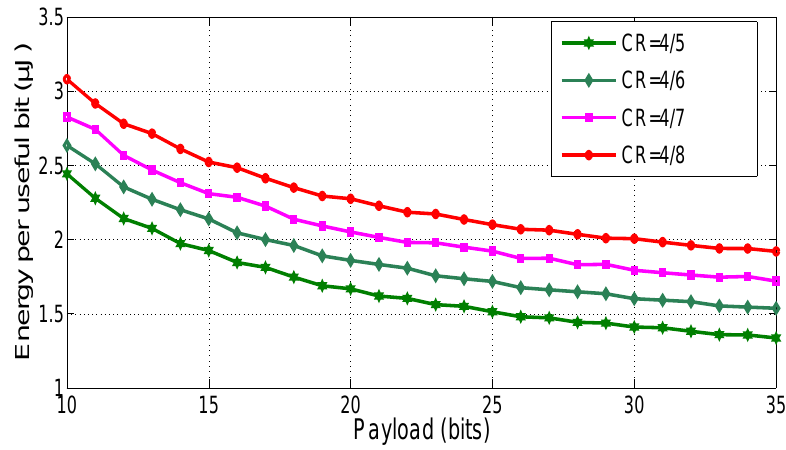
Figure 10. Effect of CR on the consumed energy, SF = 7 and BW = 500 KHz.